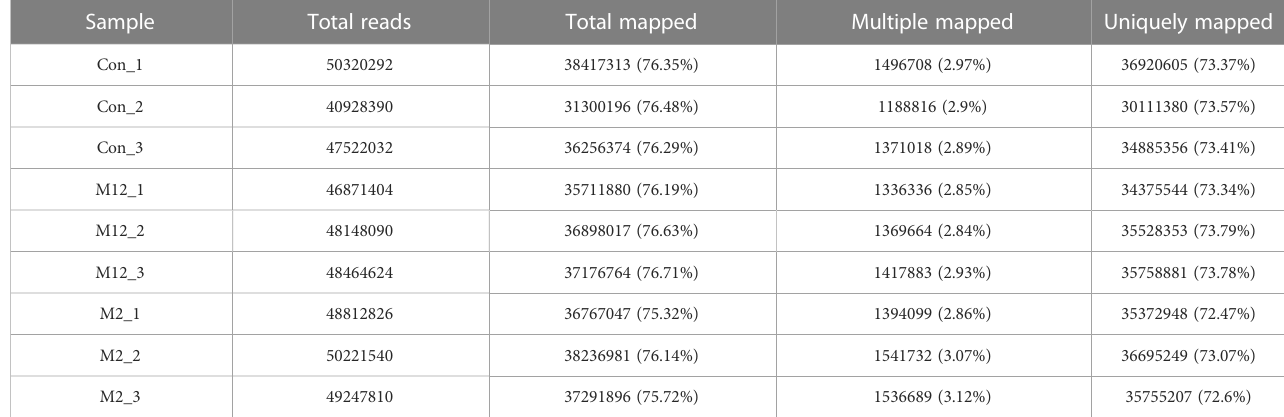
TABLE 1 Statistics of